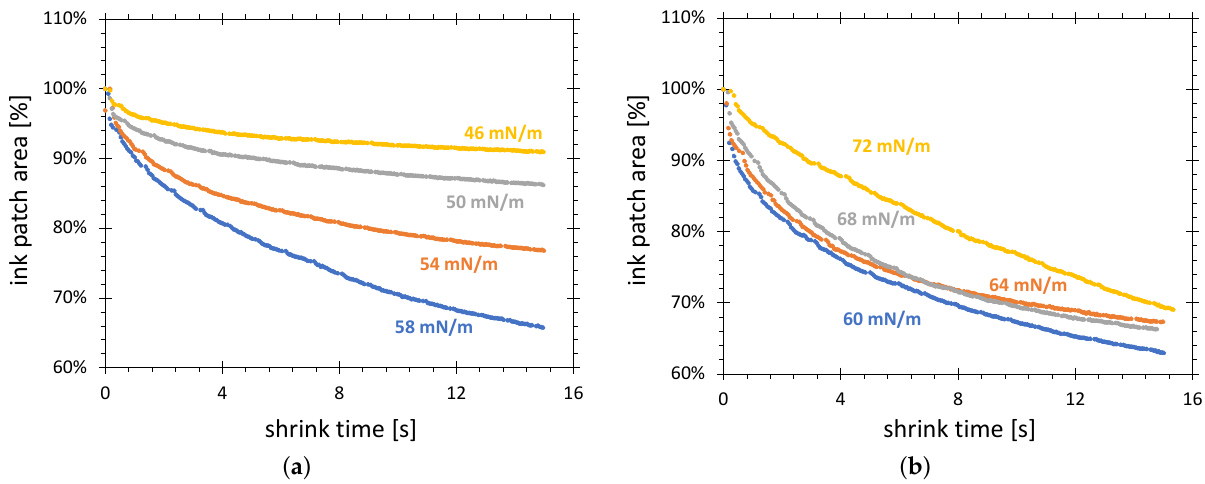
Figure 8. Comparison of relative shrinkage curves for test inks produced as mixtures of formamide with ( a ) 2-ethoxyethylene, and ( b ) water. The HDPE substrate was treated in configuration